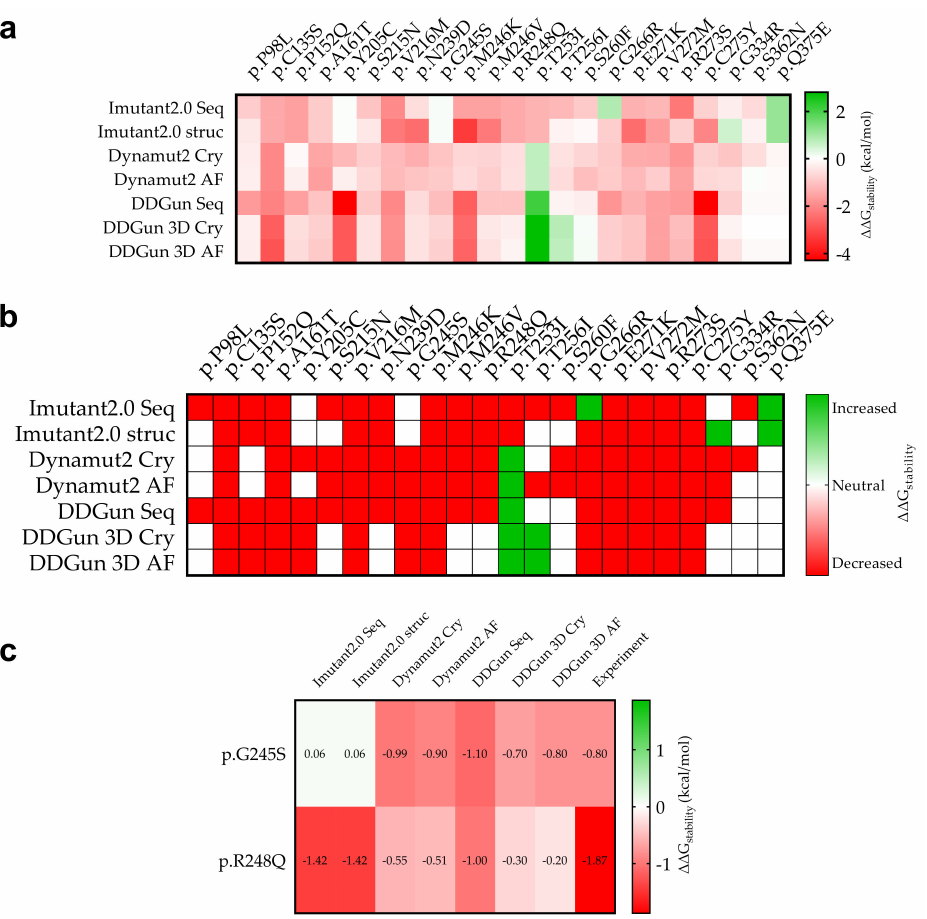
Figure 6. Stability change ( ∆∆ G stability ) due to mutation of p53 mutant proteins and experimental comparison . ( a ): The specific calculated results are shown in red (decreasing stability) and green (increasing stability). The figure shows for which mutations we calculated decreasing and increasing ∆∆ Gstability in mutant proteins in kcal/mol as a result of the mutations. ( b ): The stability change was considered as decreasing if it was less than − 0.5 kcal/mol (red) and increasing (green) if it was greater than 0.5 kcal/mol, otherwise the stability change of the mutation was considered to be neutral (white). ( c ): Two mutations p.G245S and p.R248Q that have been measured experimentally so far and their predictive comparison (see Section